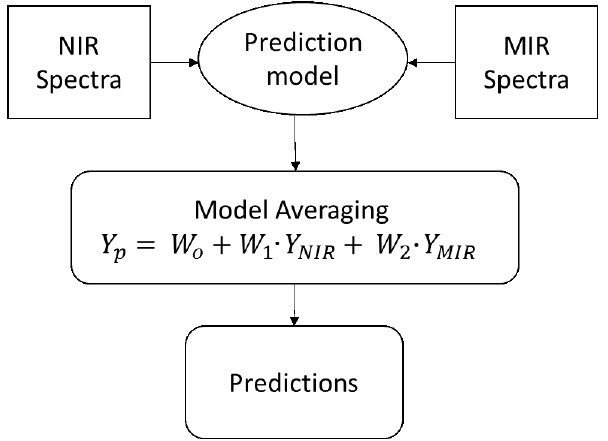
Figure 6. Model averaging for NIR and MIR